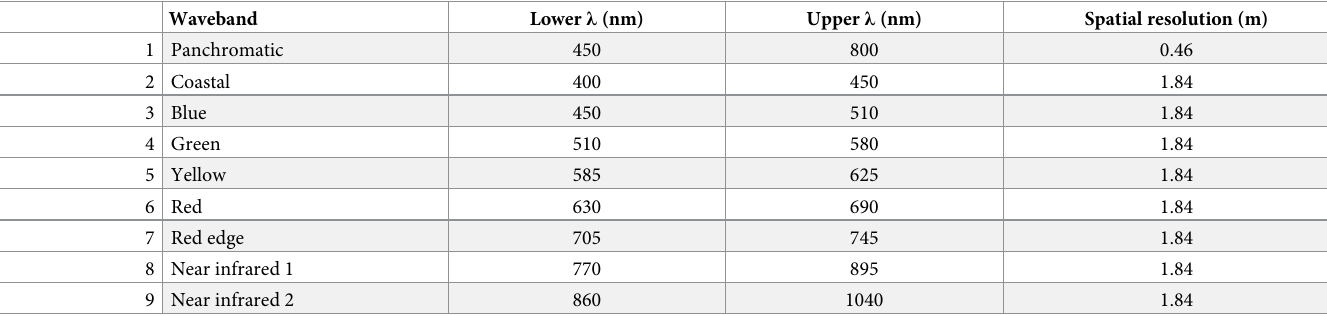
Table 1. Spectral responses of WorldView-2 indicating the lower and upper wavelength with the specific resolution of each band.